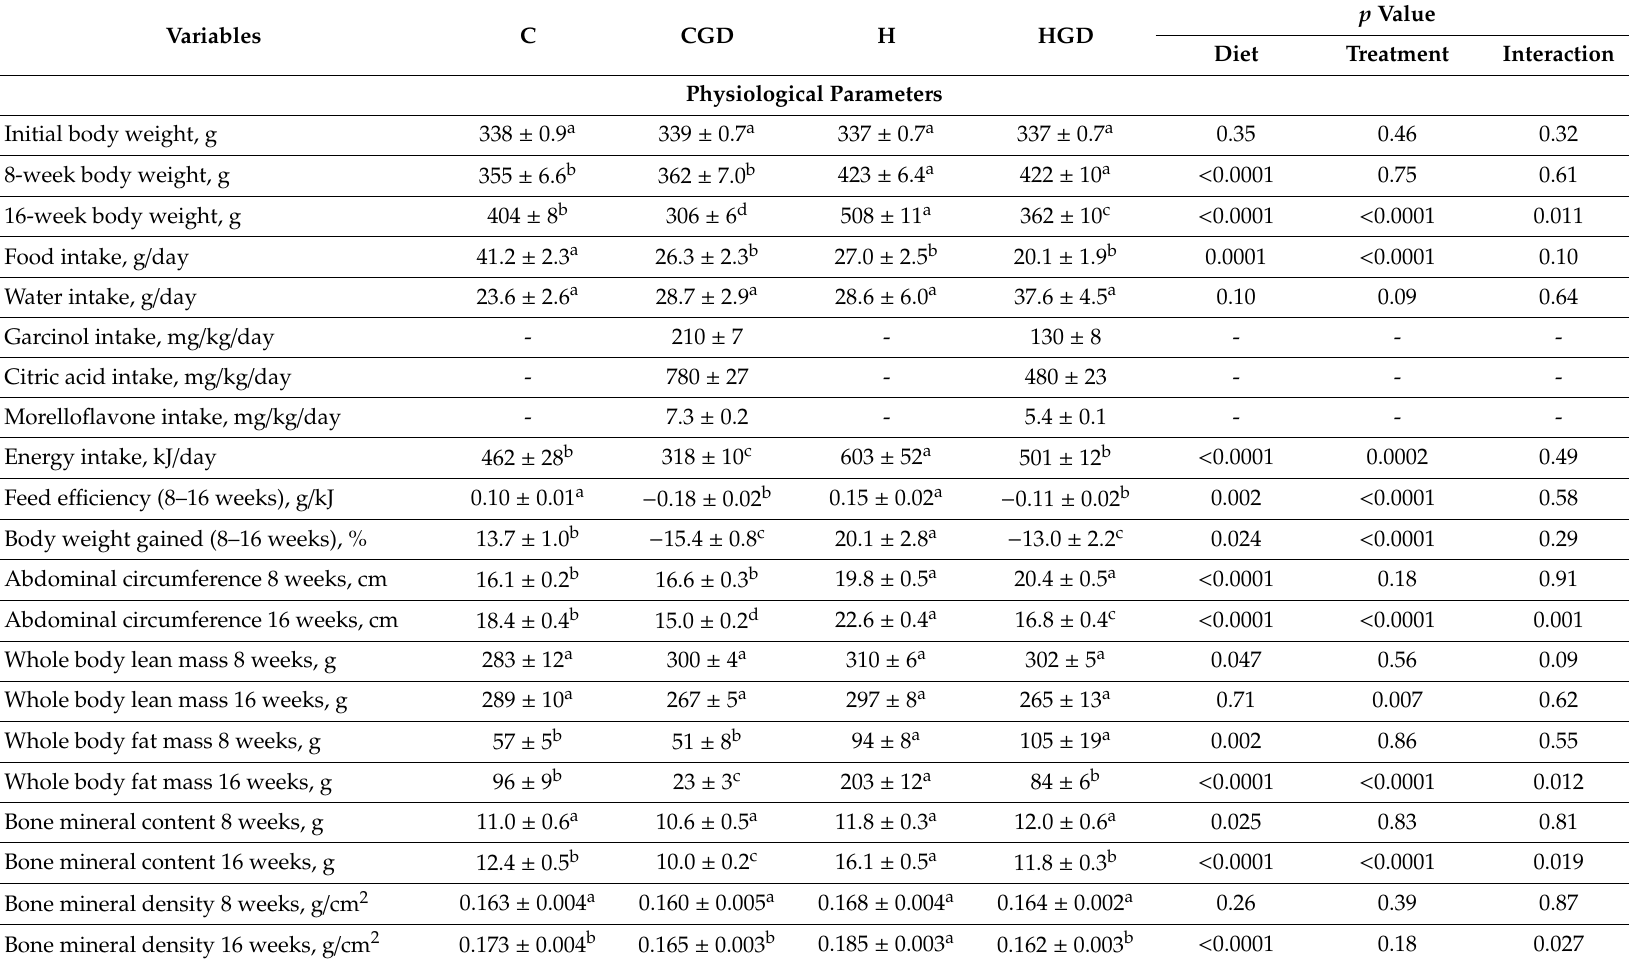
p Value Diet Treatment Interaction